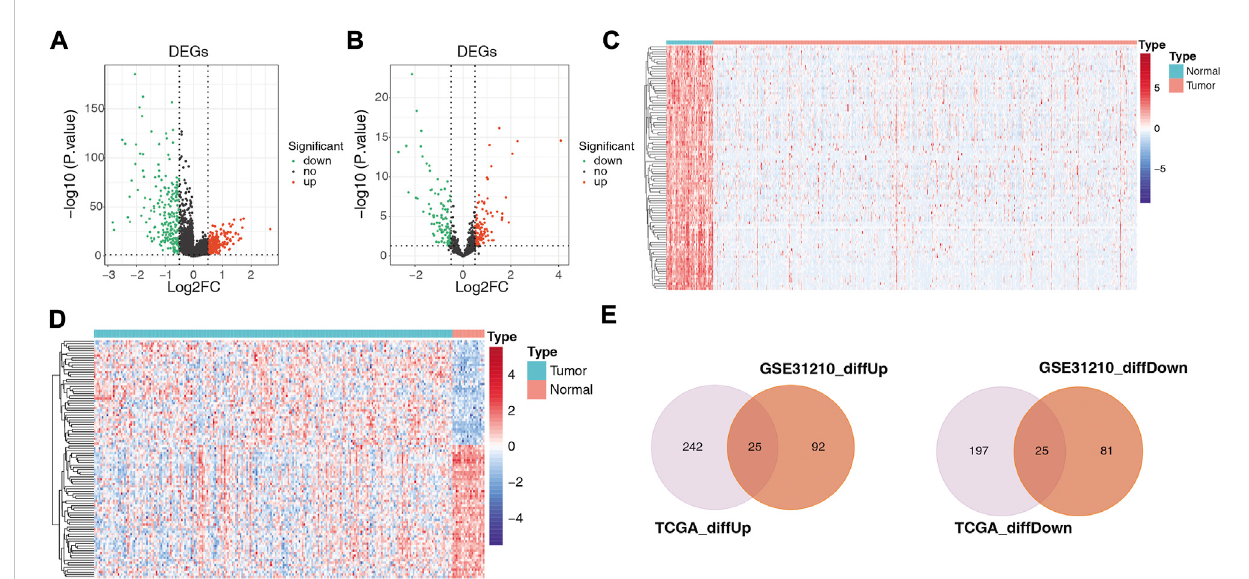
FIGURE 2 Volcano plots showing differentially expressed genes between LUAD and adjacent normal tissues in (A) 489 TCGA-DE-lncRNAs and (B) 223 GSE31210-DElncRNAs,respectively;heatmapsshowing (C) thetop100TCGA-DE-lncRNAsand (D) top100GSE31210-DE-lncRNAs sortedaccordingto p -value (ascending order), respectively GSE31210-DE-lncRNAs expression patterns in normal and tumor groups; (E) upper panel shows the intersection with DE-lncRNAs upregulated in the TGCA and GSE31210 datasets. The lower panel shows the intersection with the DE-lncRNAs downregulated in the TGCA and GSE31210